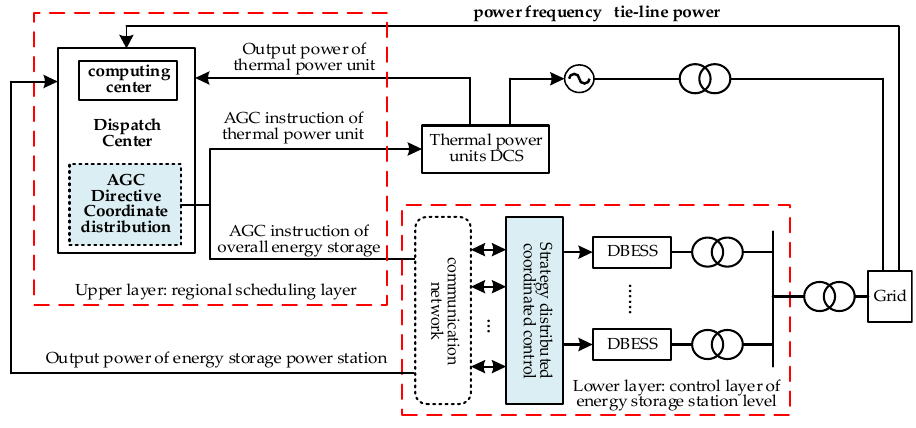
Figure 2. Two-layer coordinated control structure diagram.